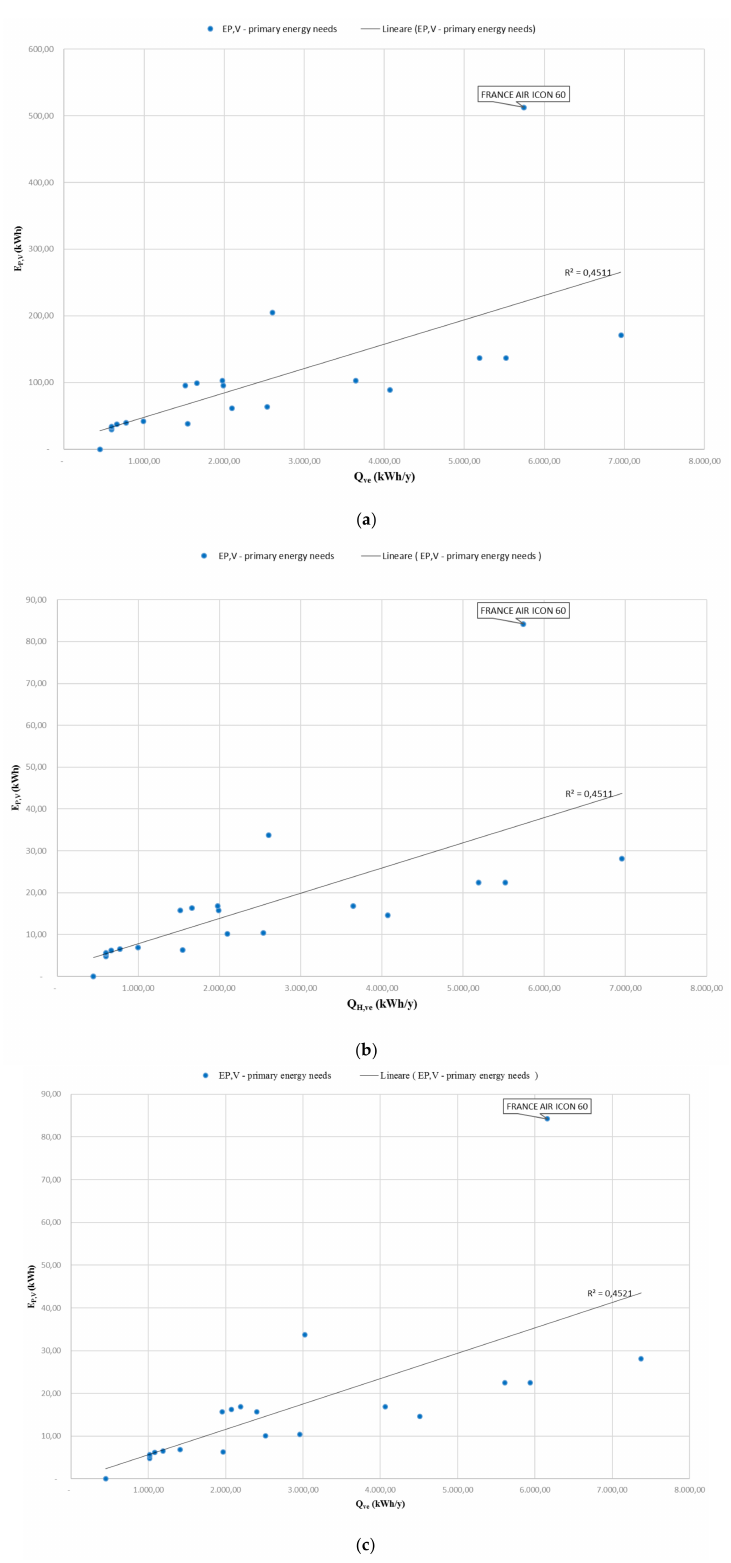
Figure 11. Relationship between Q H,ve and E P,V for the three systems of CMV ( a ) extraction; ( b ) insertion; ( c ) insertion/extraction. NB: all the figures use dots and commas as per Italian